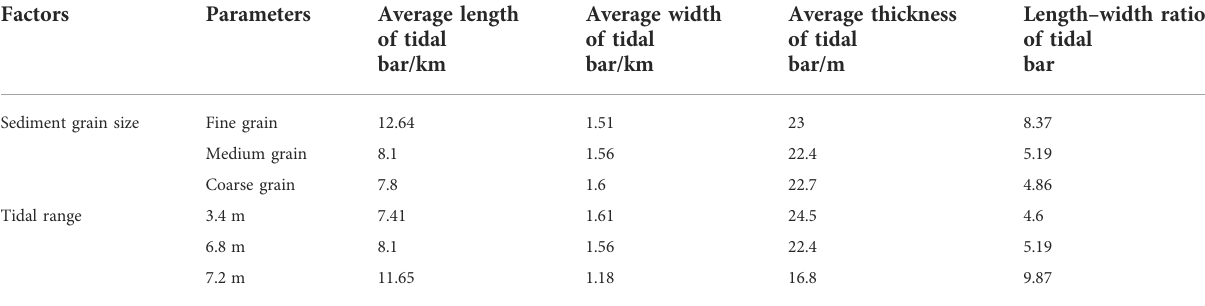
TABLE 1 Quantitative comparison of sand bar shapes under various factors in tidal-controlled estuaries.